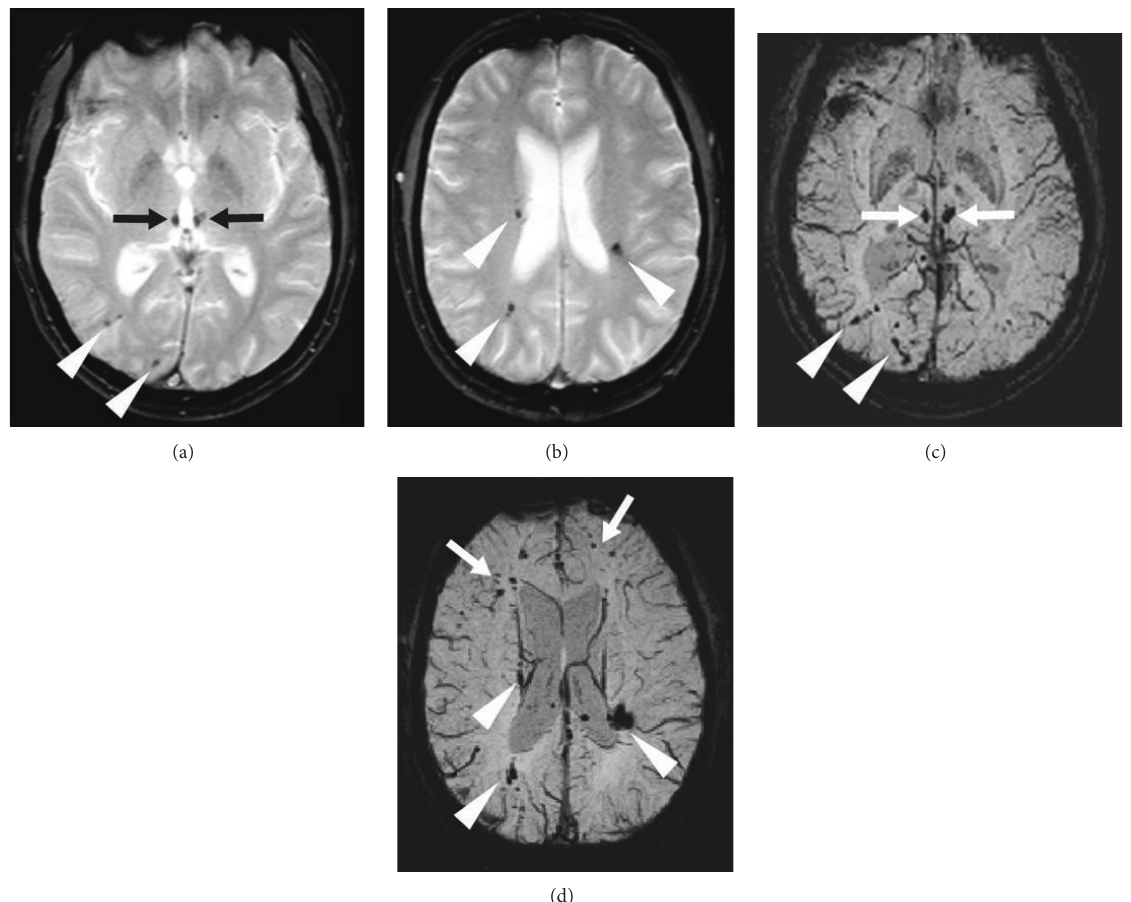
Figure 16: A patient after a major head trauma showing diffuse axonal injury with small hemorrhagic lesions in the medial part of both thalami (arrows, a) and multiple lesions near the cortico-subcortical junction (arrowheads, a and b) seen as hypointensity on gradient-echo- weighted imaging (a and b). Multiple additional lesions can be seen on SWI imaging (c and d) demonstrating the superiority of SWI imaging in diffuse axonal